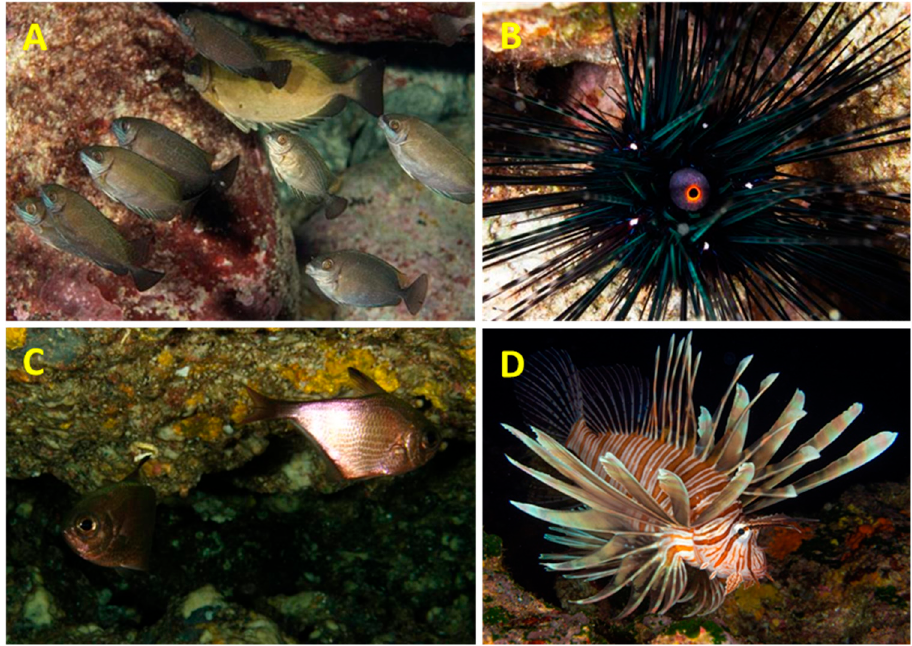
Figure 6. The NIS fish Siganus luridus ( A ) and the echinoderm Diadema setosum ( B ) from the entrance zone of Troulakas and Palatia caves, respectively. The non-indigenous fish species Pempheris rhomboidea ( C ) and Pterois miles ( D ) from the semi-dark zone of Panteleimonas and Oxonisos caves, respectively. Photos by T. Dailianis.